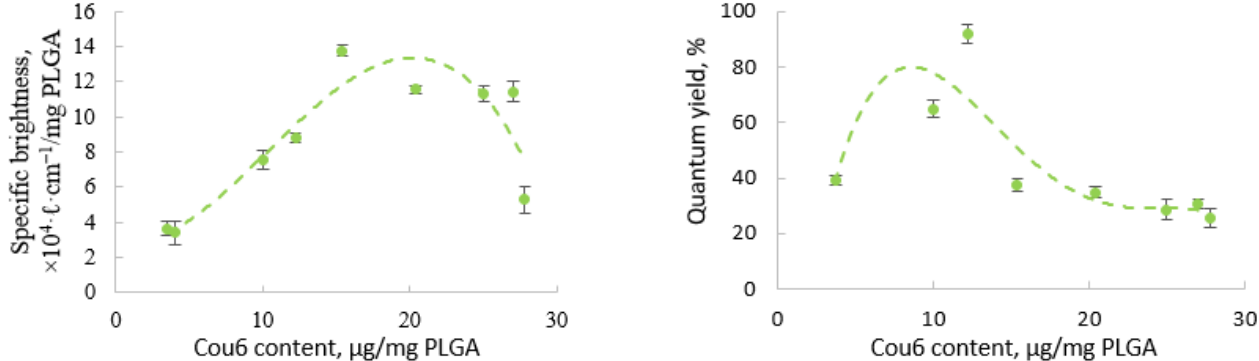
Figure 3. Influence of Cou6 content in PEG-PLGA nanoparticles on their specific brightness per mg of PLGA ( left ) and on quantum yield ( right ) ( λ EX 450